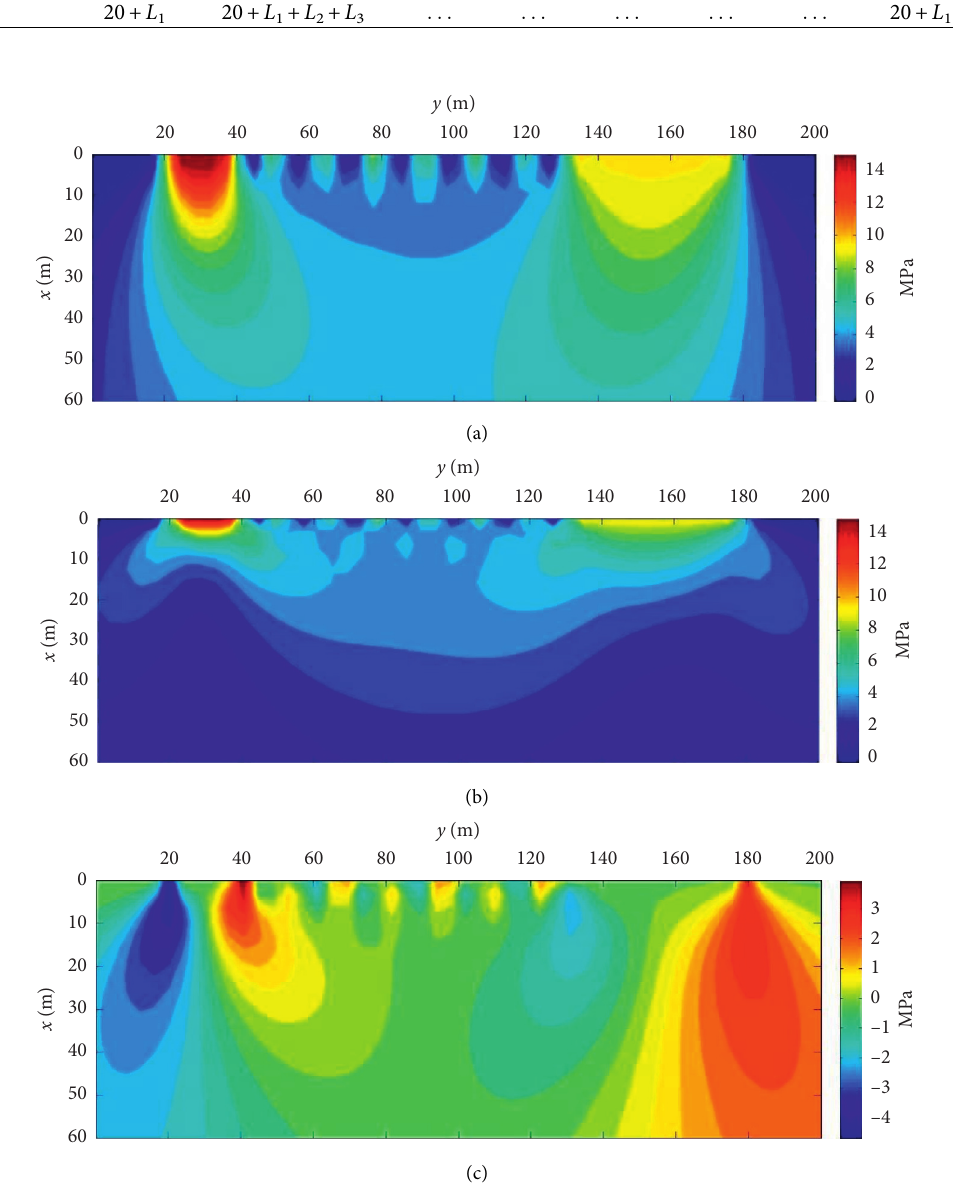
Figure 3: Stress contour under the upper seam floor. (a) Vertical stress. (b) Horizontal stress. (c) Shear